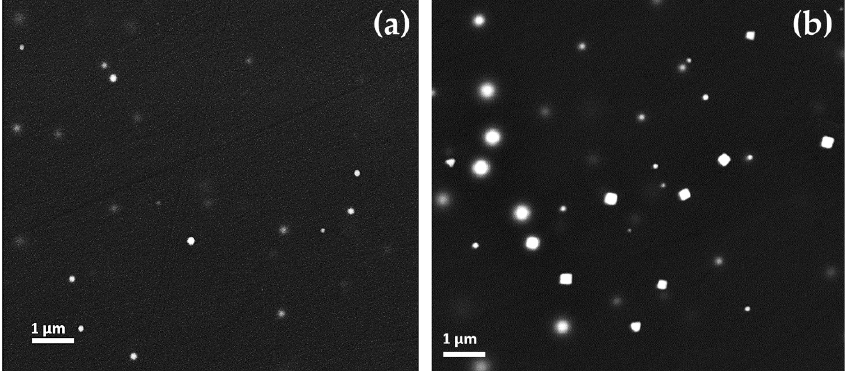
Figure 12. FEG–SEM micrographs of Gr-1 samples: ( a ) Sample R2, copper spherical nanoparticles; ( b ) copper spherical and cubic nanoparticles in sample R4.